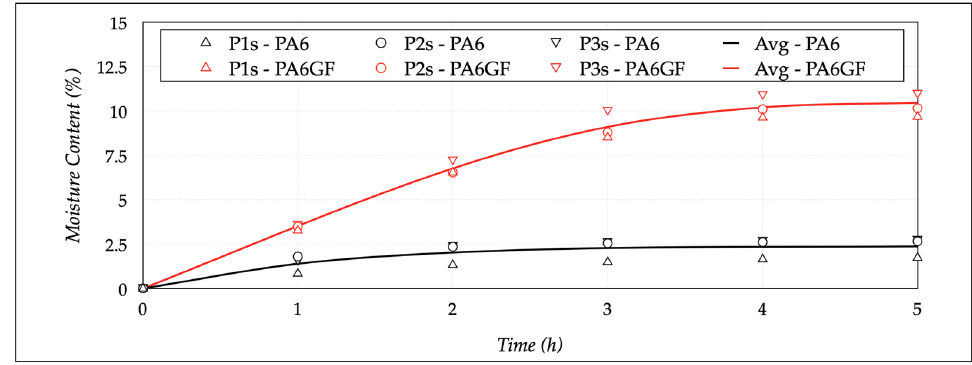
Figure 6. Results of conditioning and saturation tests with time.